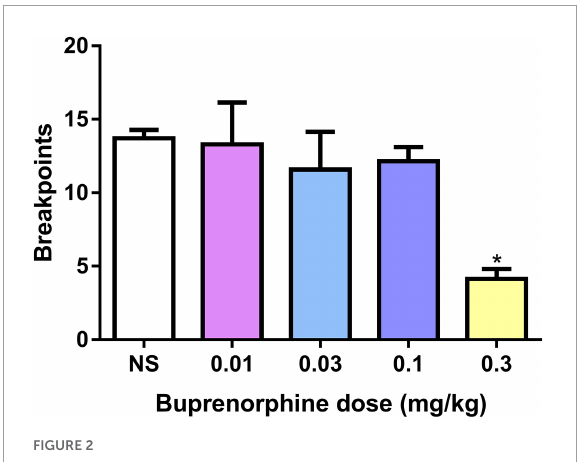
FIGURE2 Effects of buprenorphine on the motivation for methamphetamine use. The motivation for methamphetamine use expressed as the breakpoint reached under a progressive-ratio schedule of reinforcement. Values are presented as means ± SEM. * P < 0.05 vs.